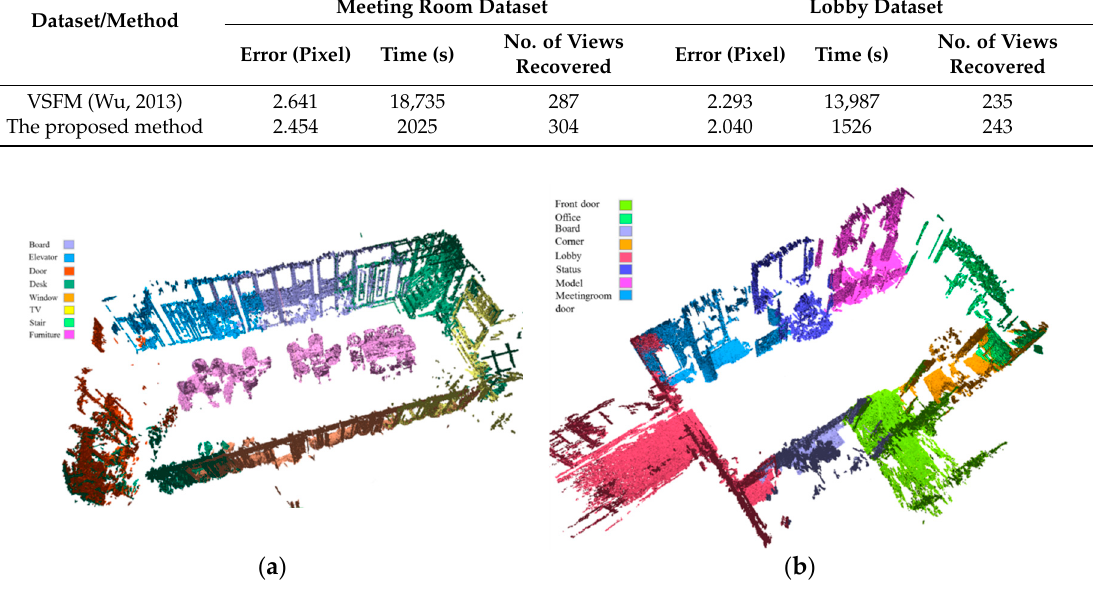
Figure 7. The semantically annotated models: ( a ) the semantically annotated model for the meeting room dataset; ( b ) the corresponding semantically annotated model for the lobby dataset.